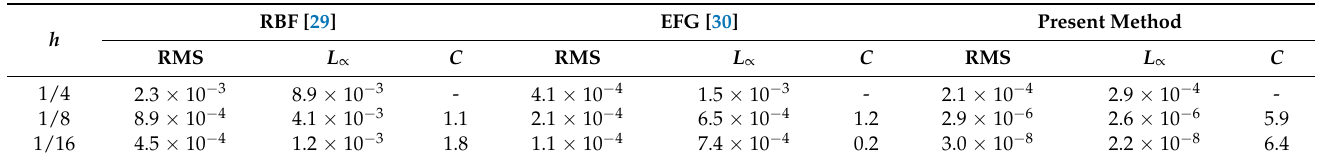
Figure 8. Present wavelet solution with Δ t = 1/2 8 and Δ h = 1/8 for Example 4. Table 6. Error norms and convergence rate in space for various numerical methods for Example 4.